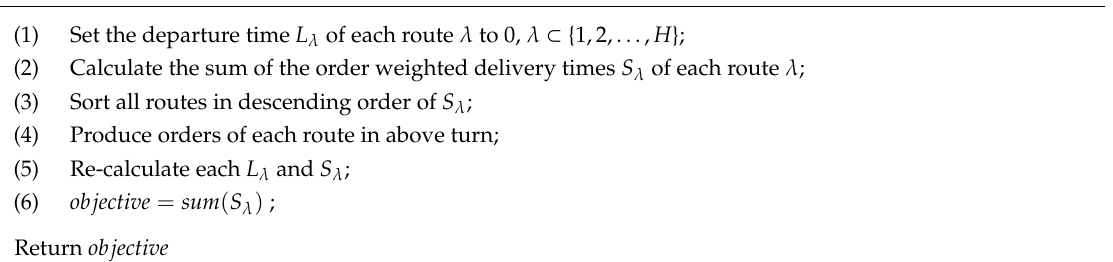
Algorithm 2: Determine the Order Production